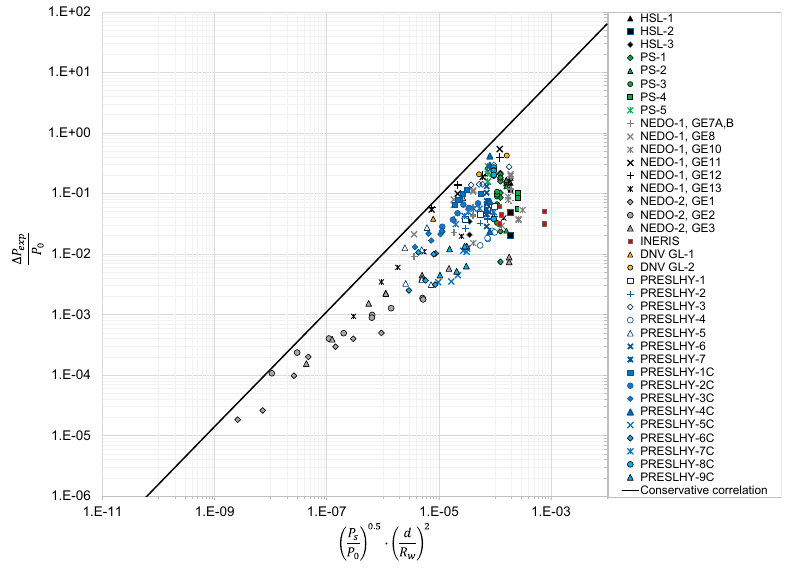
Figure 5. The conservative correlation (solid line) for the assessment of blast wave overpressure from delayed ignition of turbulent hydrogen under ‐ expanded jet (symbols denote experiments).